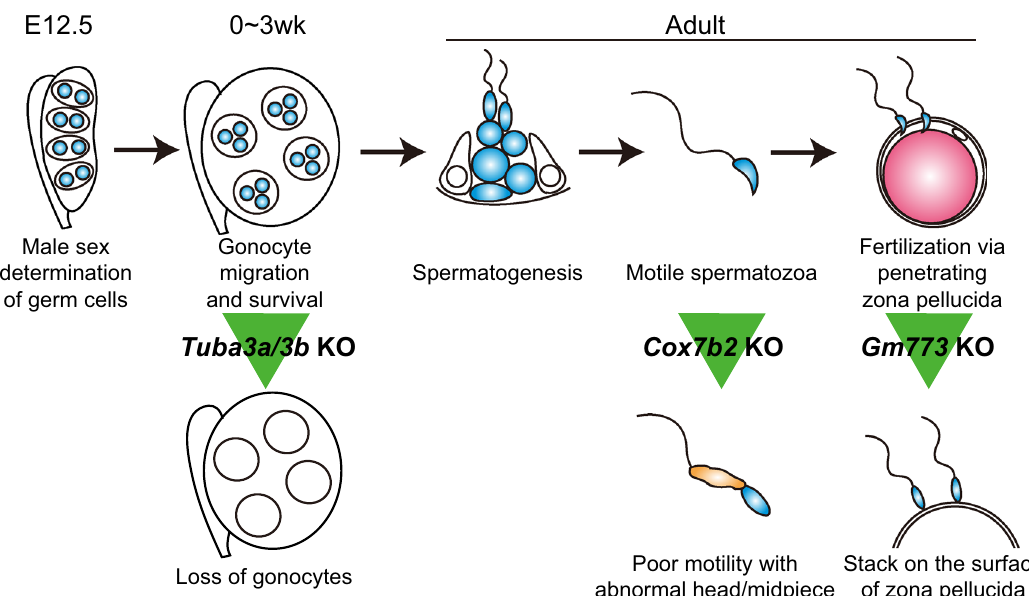
Figure 7. SRRG KO caused variable defects during male germ cell development. Schematic illustration of male germ cell development and the phenotypes observed in the SRRG KO mice in this study. Tuba3a/3b KO caused complete depletion of gonocytes at the early postnatal stages. Cox7b2 KO caused poor motility of spermatozoa, likely because of the abnormal morphology in the midpiece of spermatozoa. Gm773 KO caused a significant reduction of sperm fertility, likely because of the poor penetration capacity through zona